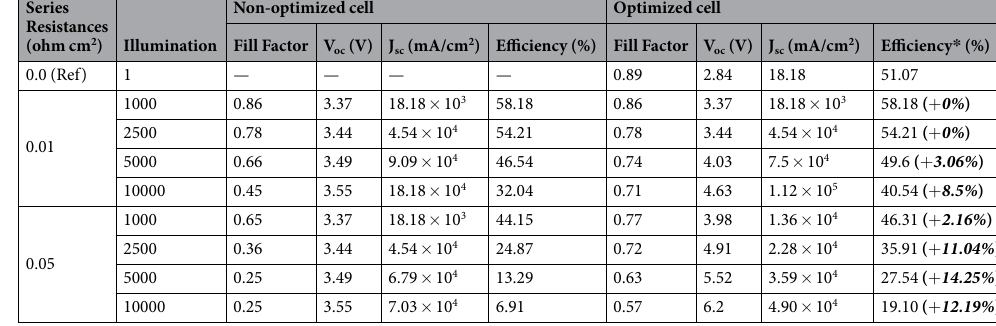
Table 2. Main photovoltaic parameters for 3-J cells with non-optimized and optimized bandgap combinations. * In parentheses: absolute efficiency gain relative to the non-optimized case.